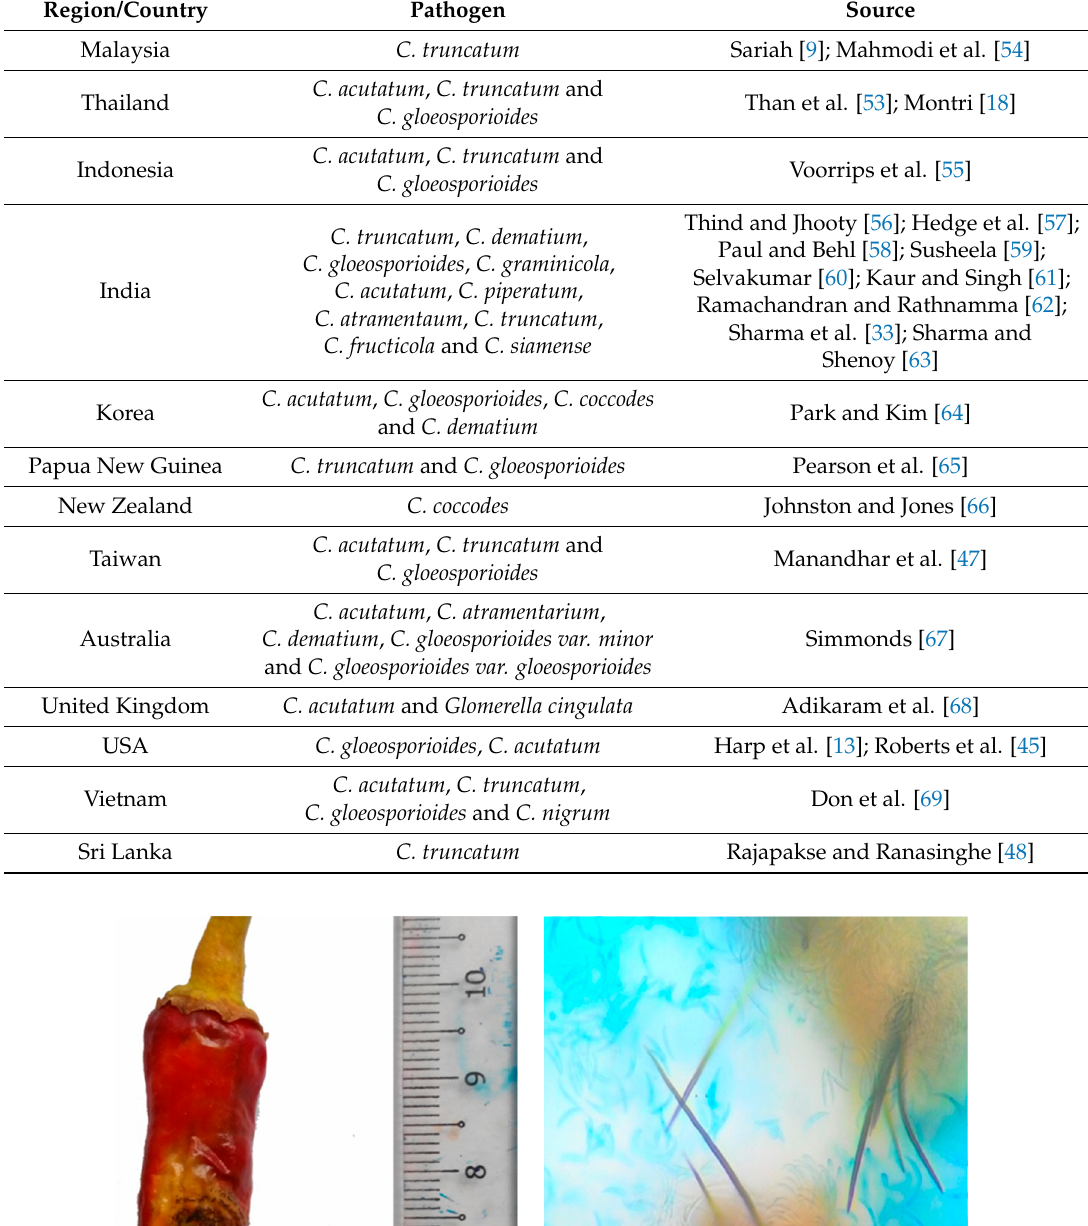
Table 1. The Colletotrichum Species, Reported as Being Causal Agents of the Chili Anthracnose Disease. Region/Country